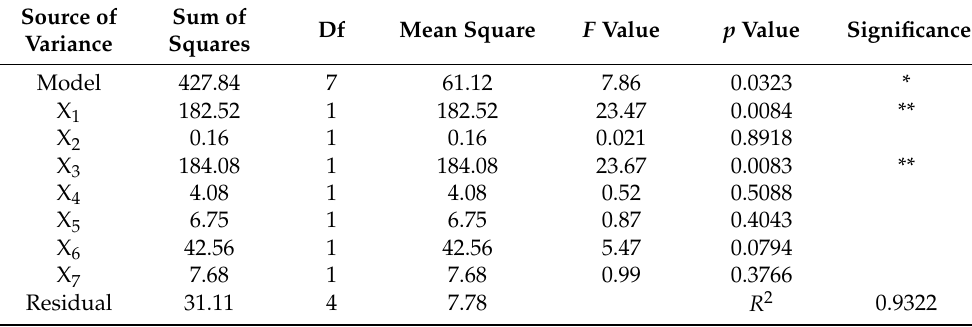
Table 5. ANOVA of the Plackett–Burman experiment. Source of Sum of Variance Squares